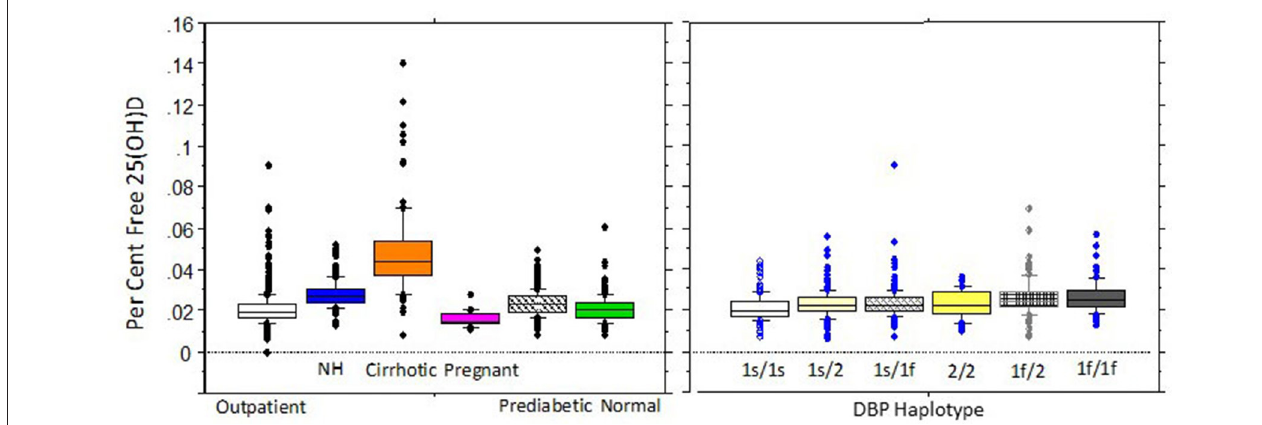
FIGURE 4 | Percent free 25(OH)D in adults by clinical condition or DBP Haplotype. Percent free 25(OH)D concentrations for selected clinical groups on the left panel (community outpatients, NH = nursing home patients, cirrhotics, pregnant women, prediabetics, and normal individuals) and by DBP haplotype on the right . Boxplots show 10th, 25th, median, 75th, and 90th percentile values. Individual points represent values above the 90th and below the 10th percentiles. Both clinical subgroup and DBP genotype significantly effect percentage free 25(OH)D. Between group comparisons for clinical conditions were significant for all but healthy persons compared with pregnant women or outpatients, or for pregnant women compared with outpatients. For DBP haplotypes, smaller but significant differences were detected between the 1s/1s haplotype and the 1s/1f,1f/2, 1f/1f, and 1s/2 haplotypes and between the 1s/2 and 1f/2 and 1f/1f haplotypes and between the 1s/1f and 1f/1f haplotypes. Data are reproduced with permission from Schwartz et al.